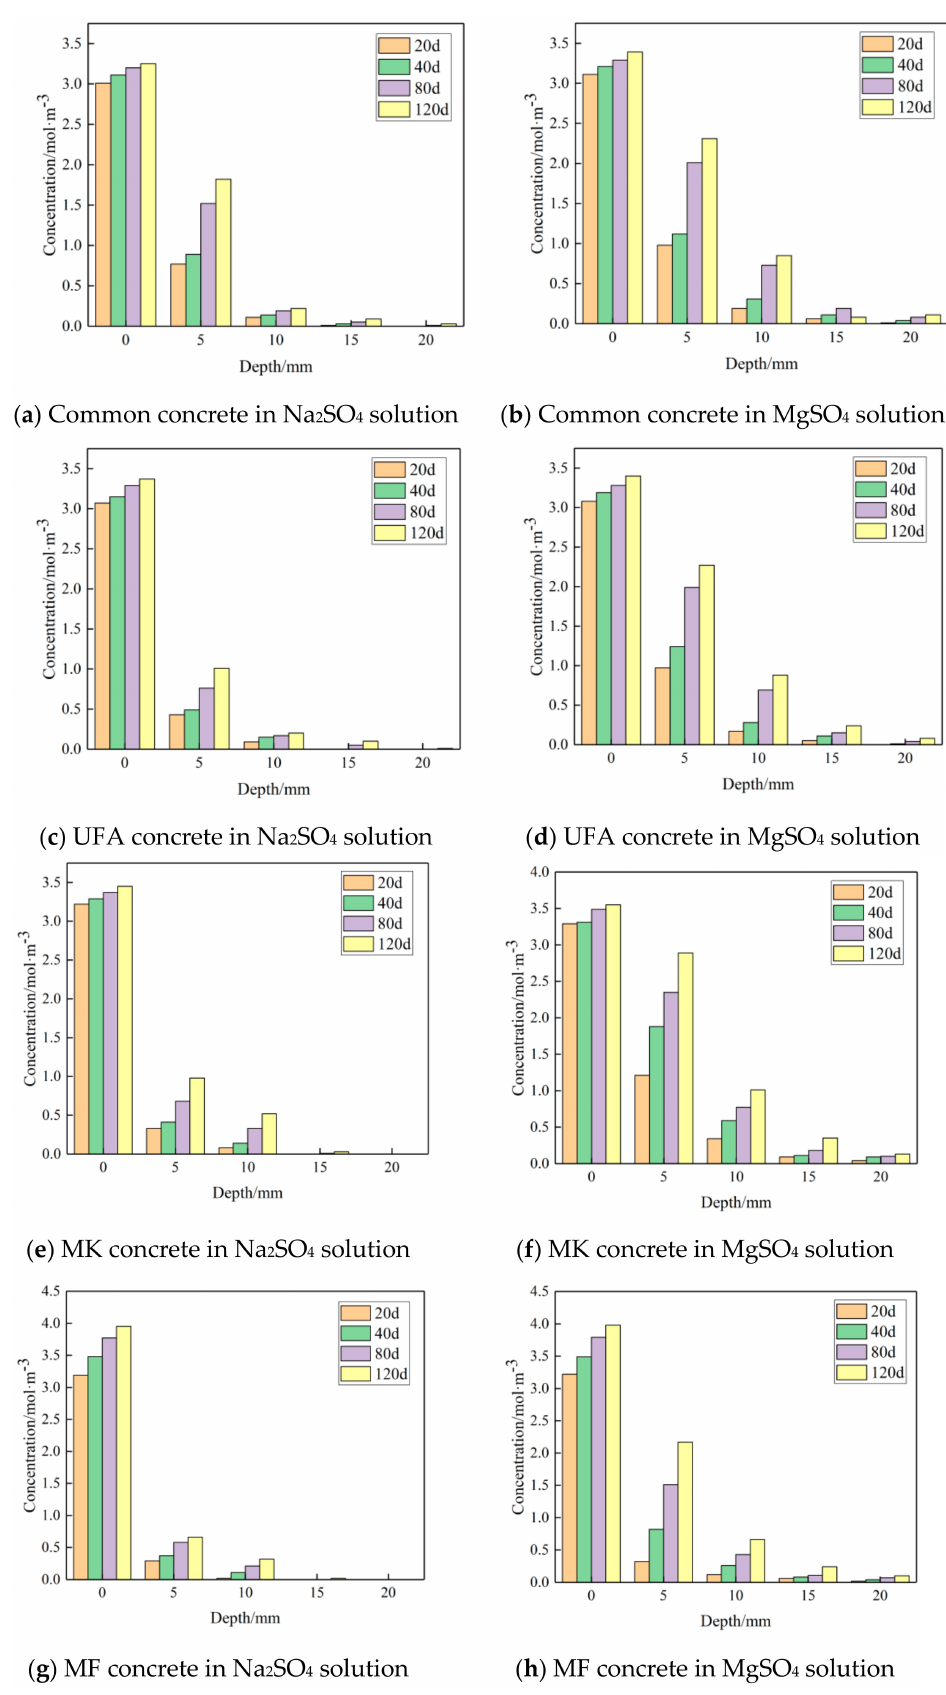
Figure 6. Sulfate ion test values at different erosion cycles and